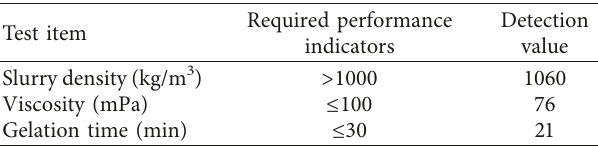
Figure 5: The test sensors and their wires installed on the ballastless track-subgrade. Table 1: The major performance parameters of the mixed slurry of the LVER.